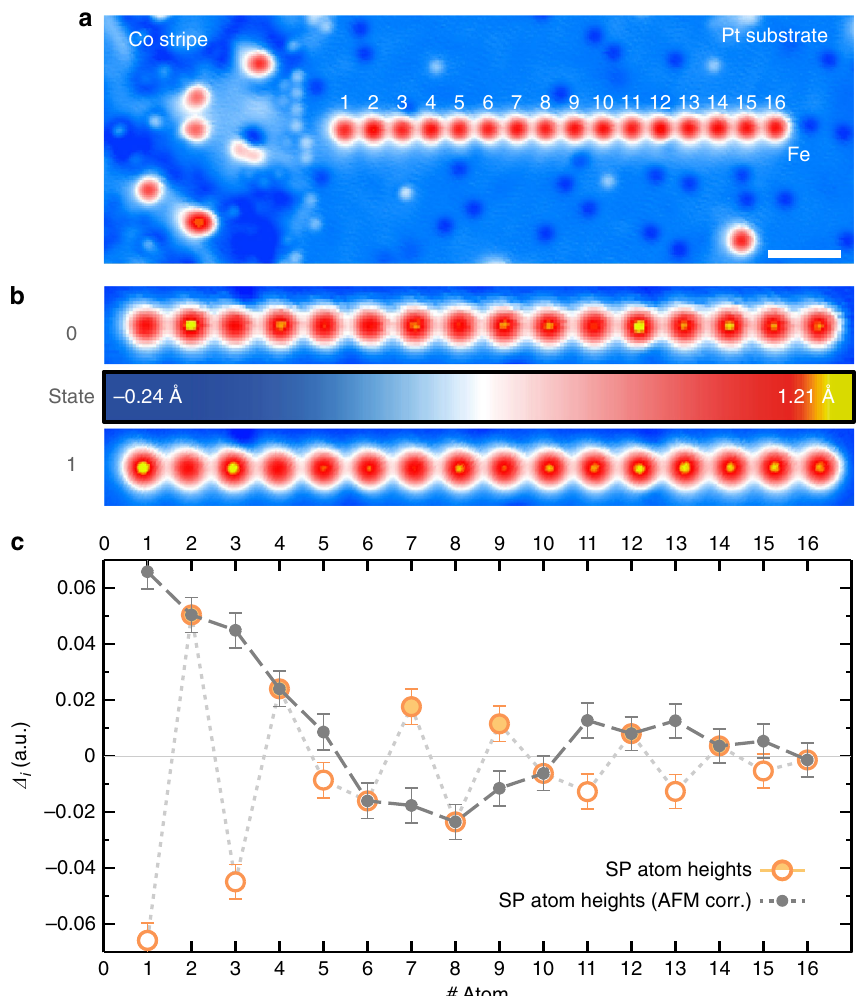
Fig. 4 Spin-spiral in Fe 16 chain coupled to a Co stripe. a STM topograph of an Fe 16 chain with d NN = 3 a RKKY-coupled to a ferromagnetic Co stripe on the left. ( I s = 0.5 nA, V s = 6 mV). The white scale bar has a length of 2 nm. b SPSTM images of the two states 0 and 1 of the Fe 16 chain stabilized by the two magnetization states of the Co stripe taken with out-of-plane sensitive tip ( B z = 0 T, I s = 0.5 nA, V s = 6 mV). The magnetic state of the Co stripe was reversed between top and bottom image. c Spin-asymmetry Δ i between states 1 and 0 of atom i of the Fe 16 chain taken from the images in b (see text). For the gray points, the short-range antiferromagnetic component has been removed by reversing the sign of all even numbered atoms, such that the long range spin-spiral component is visible. The error bars were determined via error propagation from the standard deviation of each measured height (measured three